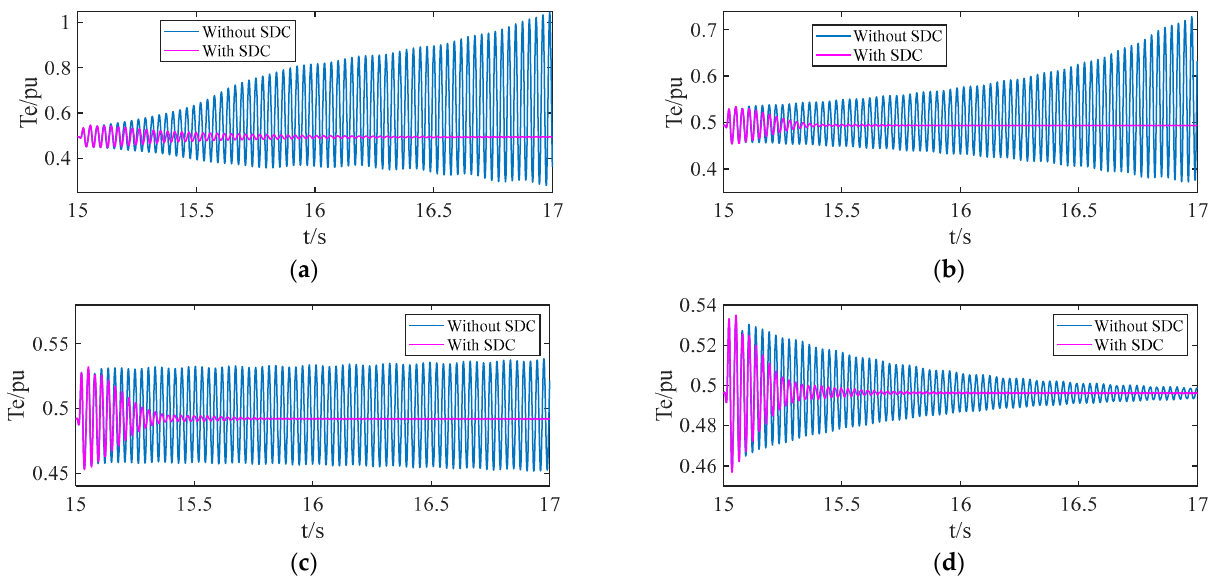
Figure 12. Effect comparison of the system with and without SDC under different operating conditions: ( a ) compensation degree of 20%; ( b ) k p3 = 0.52; ( c ) k i3 = 1; ( d ) k p1 = 1.3.